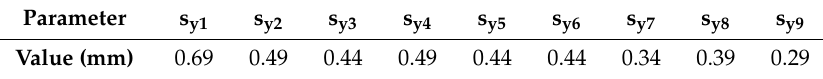
Table 2. Separation distances between the slanted slots.